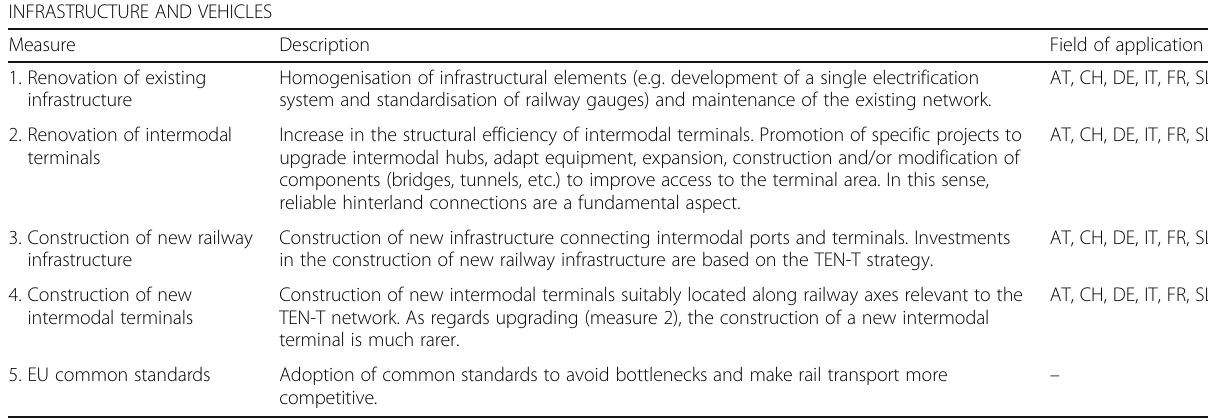
Table 3 List of measures belonging to the “ Infrastructure and vehicles ” group INFRASTRUCTURE AND